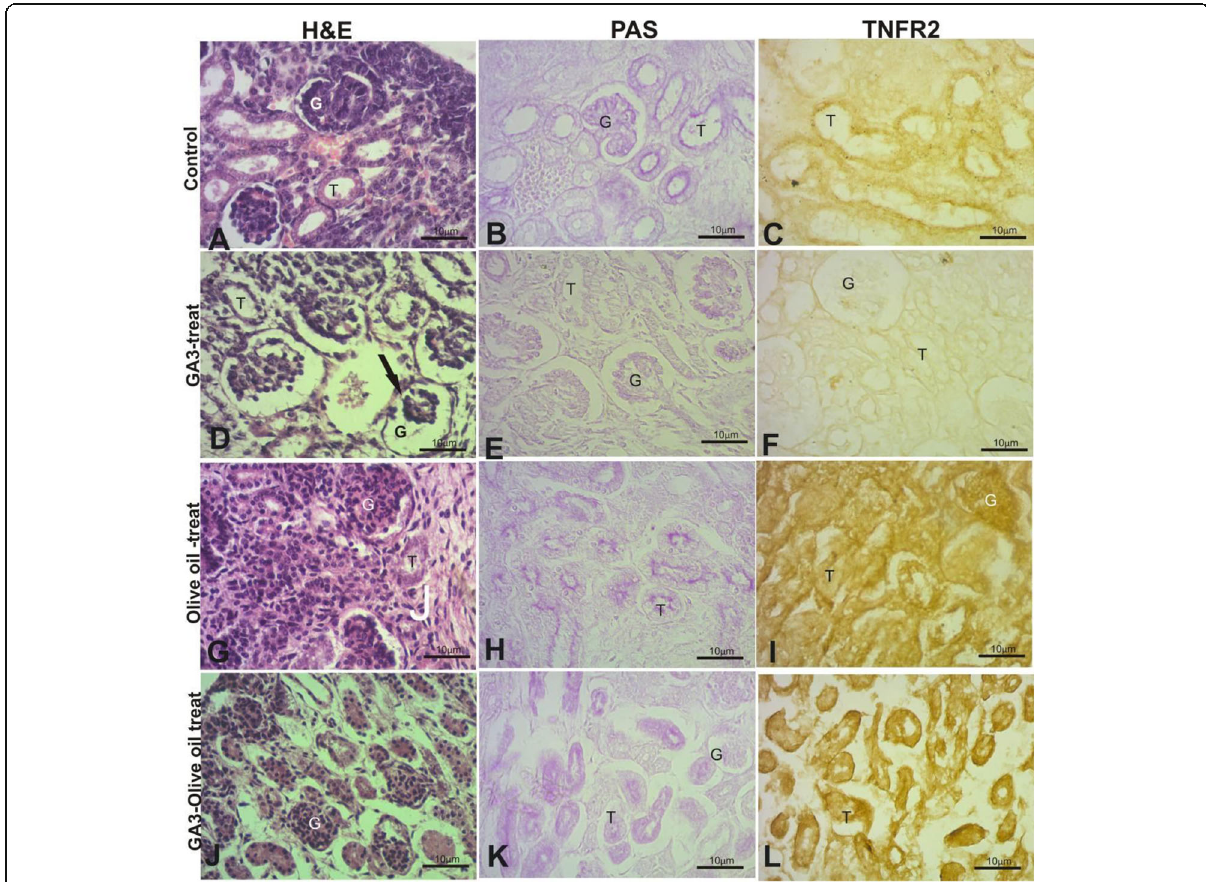
Fig. 7 Photomicrographs of H&E-, PAS-, and TNFR2-stained sections of developing kidney at E18. The control of developing kidney at E18 of gestation showed glomerulus (G), and tubules (T) ( a ). The kidney tubules showed positive carbohydrates (PAS reaction) ( b ) and TNFR2 expression ( c ). GA3-treated embryos revealed kidney of pale-staining, tubule degeneration, shrinkage of renal corpuscles (arrow, d ), decrease stainability of carbohydrates ( e ) and TNFR2 localization ( f ). Olive oil-treated embryo showed similar kidney structure such that observed in the control but an increase in the expression of TNFR2 was noted ( g – i ). The kidney in the GA3-olive oil-treated embryos revealed improvement in the alterations that induced by GA3 ( j – l ). Scale bar ( a – l ) = 10 μ